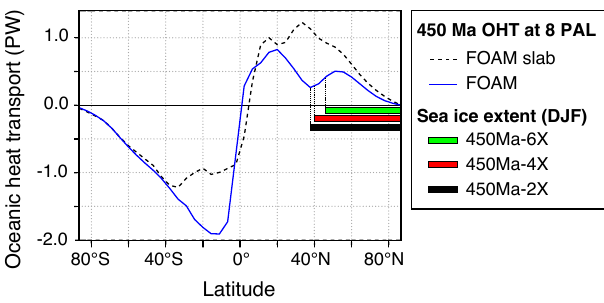
Figure 12. Comparison of the total OHT at 450Ma and at 8PAL for the slab version of FOAM and for the fully coupled version of FOAM. The OHT pattern is relatively stable when CO 2 is varied. Color bars represent the maximum (boreal winter) Northern Hemi- sphere sea ice extent simulated within the cold climatic mode at 450Ma with the fully coupled